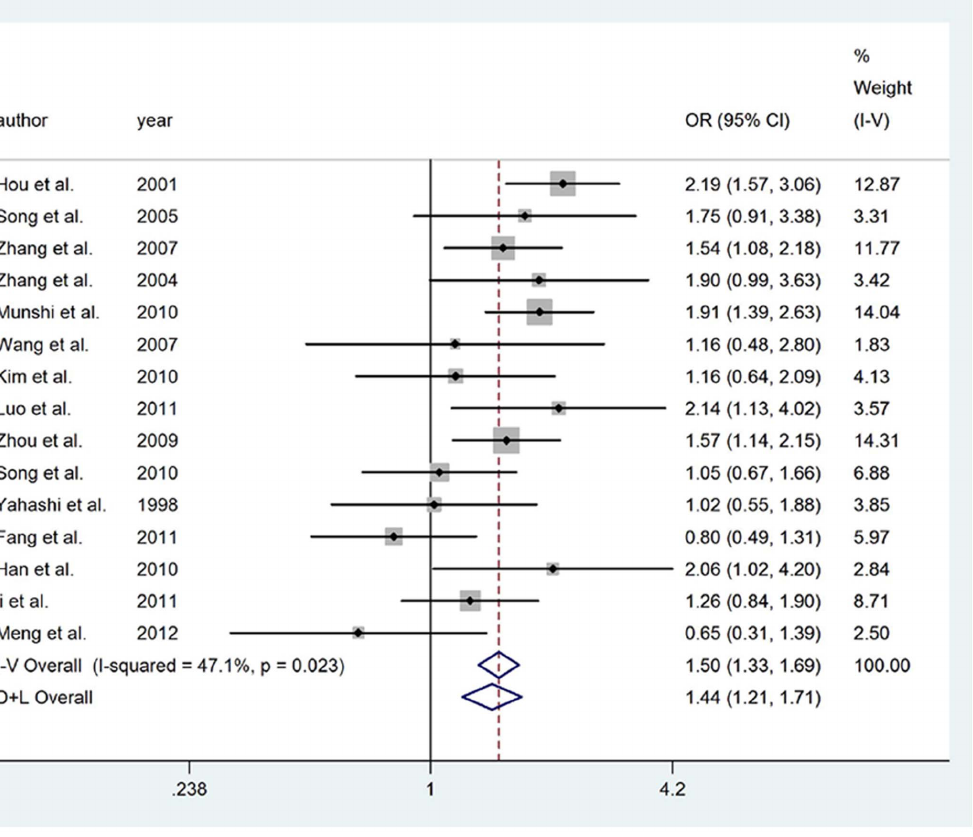
Figure 2. Meta-analysis for IS risk depending on the 4b/a polymorphism in the eNOS gene. Forest plots of relationship between eNOS gene 4b/a polymorphism and IS risk in dominant model after excluding articles that that deviated from HWE in controls in Asian. White diamond denotes the pooled OR. Black squares indicate the OR in each study, with square sizes inversely proportional to the standard error of the OR. Horizontal lines represent 95% CIs.